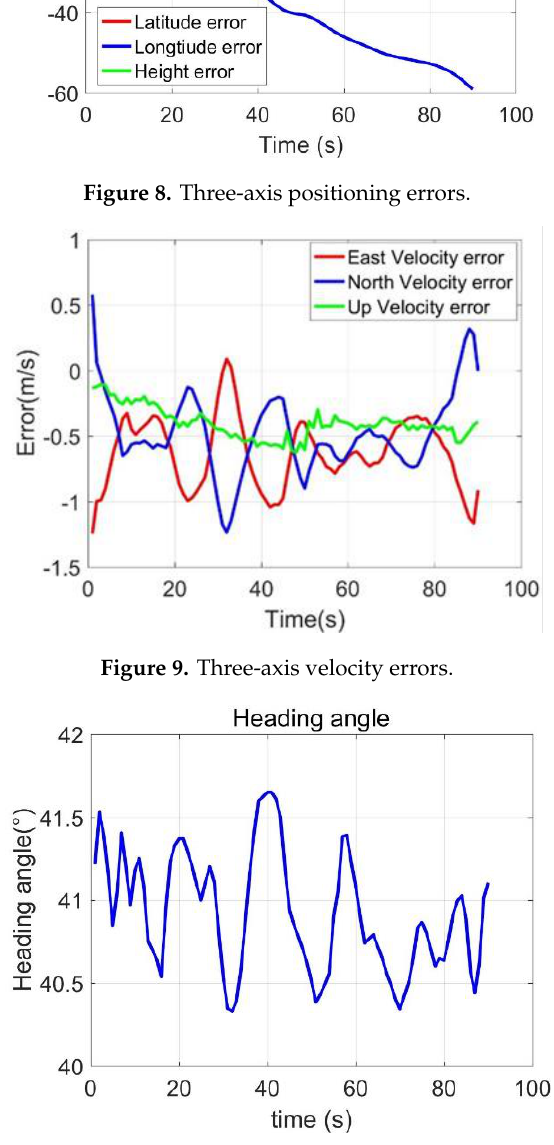
Figure 10. Heading angle. Figure 10. Heading